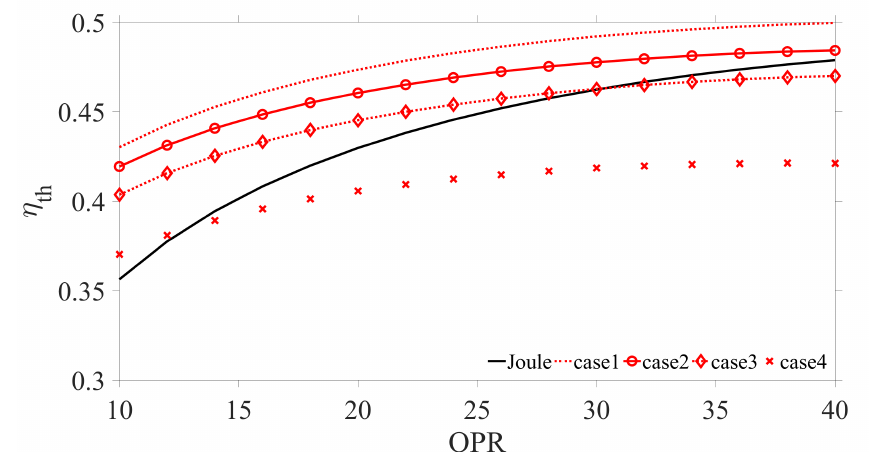
Figure 8. Cycle thermal efficiency as a function of compressor pressure ratio for the Joule cycle and the four versions of the Humphrey cycle presented in Table 3. TIT: 1700 ◦ C.